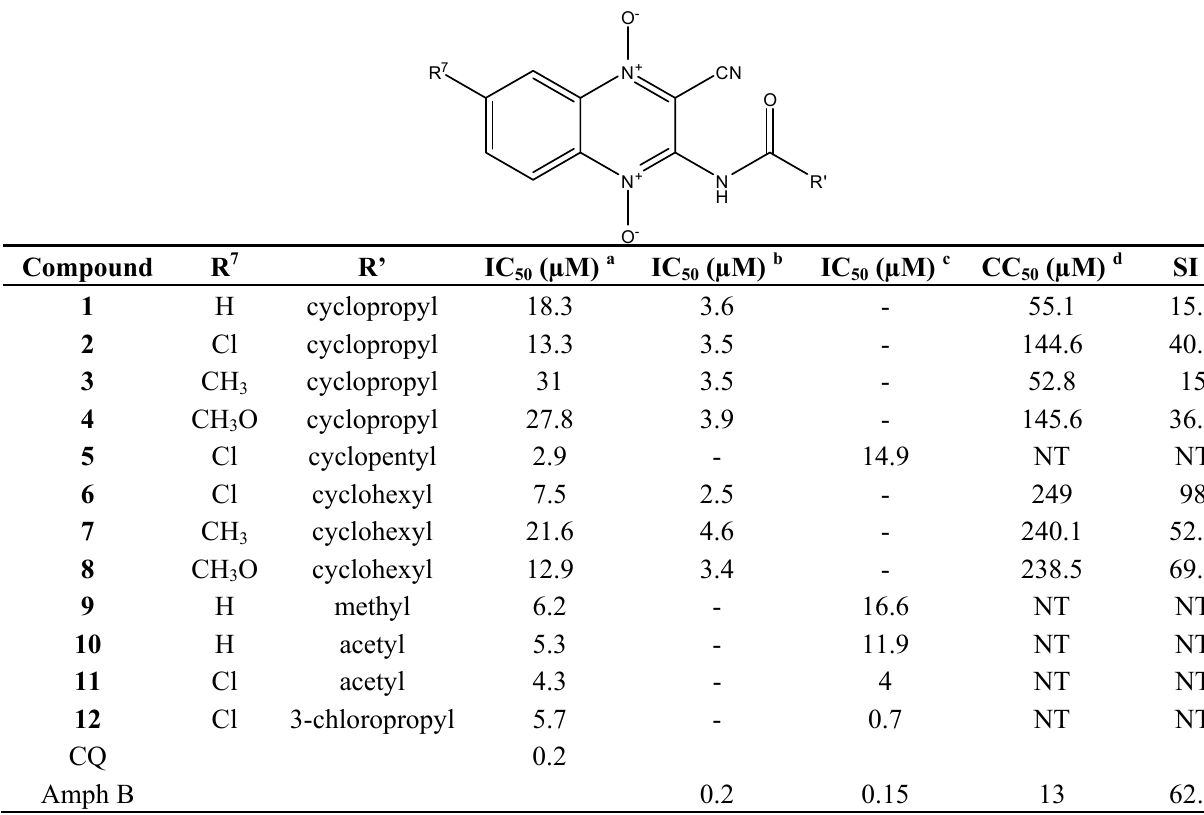
Table 1. Biological characterization of the final compounds.